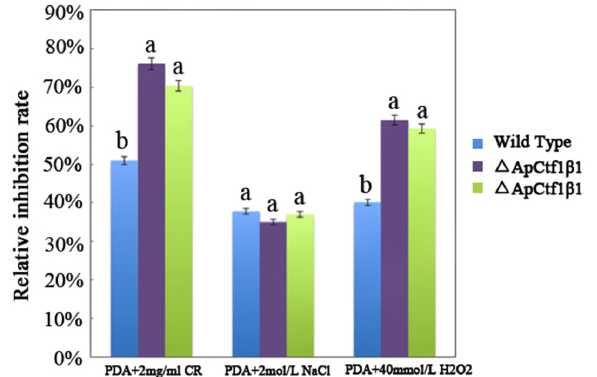
Figure 12. The bar chart showed the relative inhibition rate of wild type, Δ Ap Ctf1 β 1 and Δ Ap Ctf1 β 2 strains after CR, NaCl and H 2 O 2 stress for 5 days, respectively. Note: The datasets were calculated from the image in Figure 11. The error bars represent the standard deviations based on three independent biological replicates with three technical replicates each. The relative inhibition rate of ∆ Ap Ctf1 β 1 and ∆ Ap Ctf1 β 2 were significantly different from that of wild type after CR and H 2 O 2 stress. The relative inhibition rate of ∆ Ap Ctf1 β 1 and ∆ Ap Ctf1 β 2 were consistent with that of wild type after NaCl stress. All assays were repeated three times, the data were analyzed using one-way ANOVA and Duncan’s range test in SPSS 16.0. Different lowercase letters showed that the relative inhibition rates of Congo red, NaCl and H 2 O 2 on the mycelial growth of different strains were significantly different ( p ≤